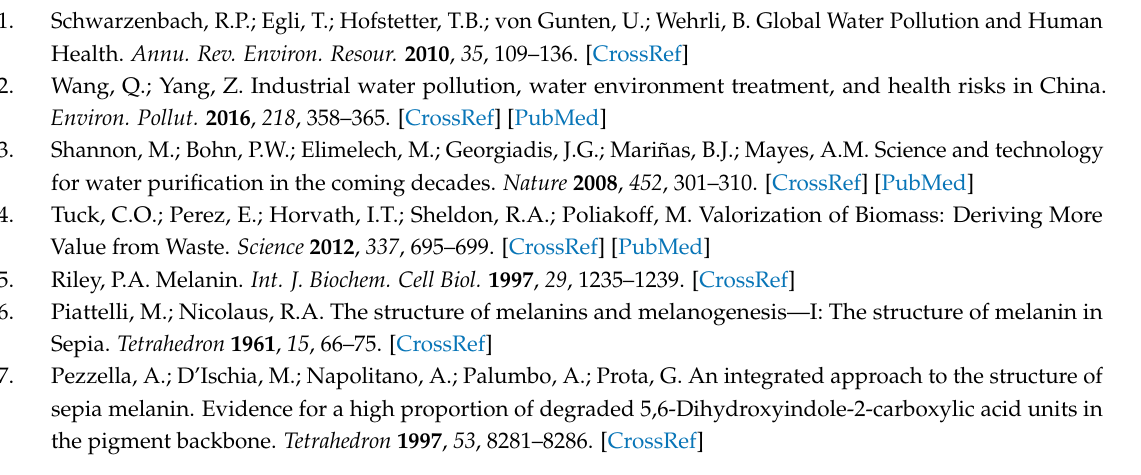
Figure S1: SEM image of a sepia melanin granule showing the spherical particles it is made of, Figure S2: FTIR spectra of sepia melanin, P(E- alt -MA) and of the sepia melanin-P(E- alt -MA) hybrid, Figure S3: Evaluation of the adsorption efficiency of sepia melanin for methylene blue as a function of pH. Conditions: 1 g L − 1 of adsorbent, 50 mg L − 1 of methylene blue, 30 min, 250 rpm, 25 ◦